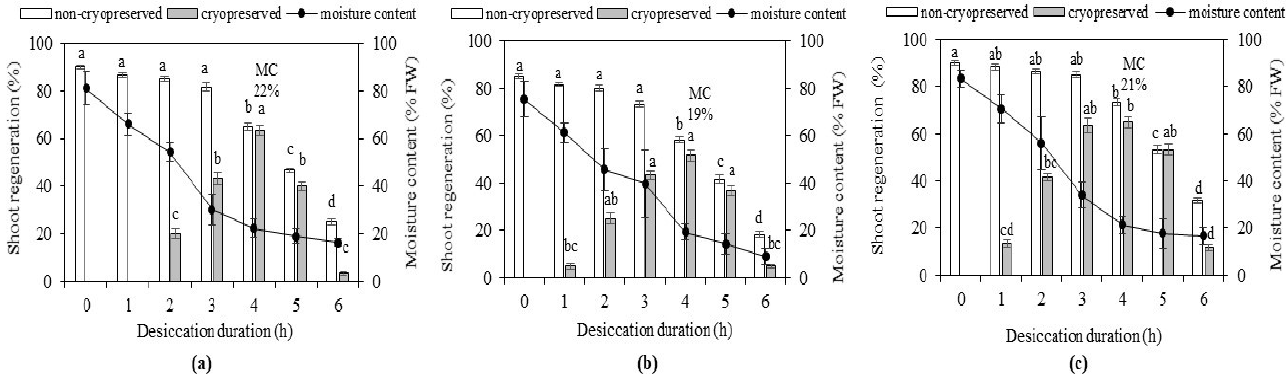
Figure 3. Shoot regeneration from alginate-coated non-cryopreserved (−LN) and cryopreserved (+LN) shoot tips according to the bead moisture content (MC) and the desiccation duration: ( a ) cv. ‘Ioana’, ( b ) cv. ‘Mariana’ and ( c ) cv. ‘Vulcan’. Osmoprotection was made in 0.75 M sucrose solution for 24 h at 23 ± 1 °C during a 16 h light photoperiod. The indicated MC values represent percentages leading to the highest regeneration rates for each cultivar. Vertical bars represent standard deviation. Different letters indicate significant differences ( P ≤ 0.05).